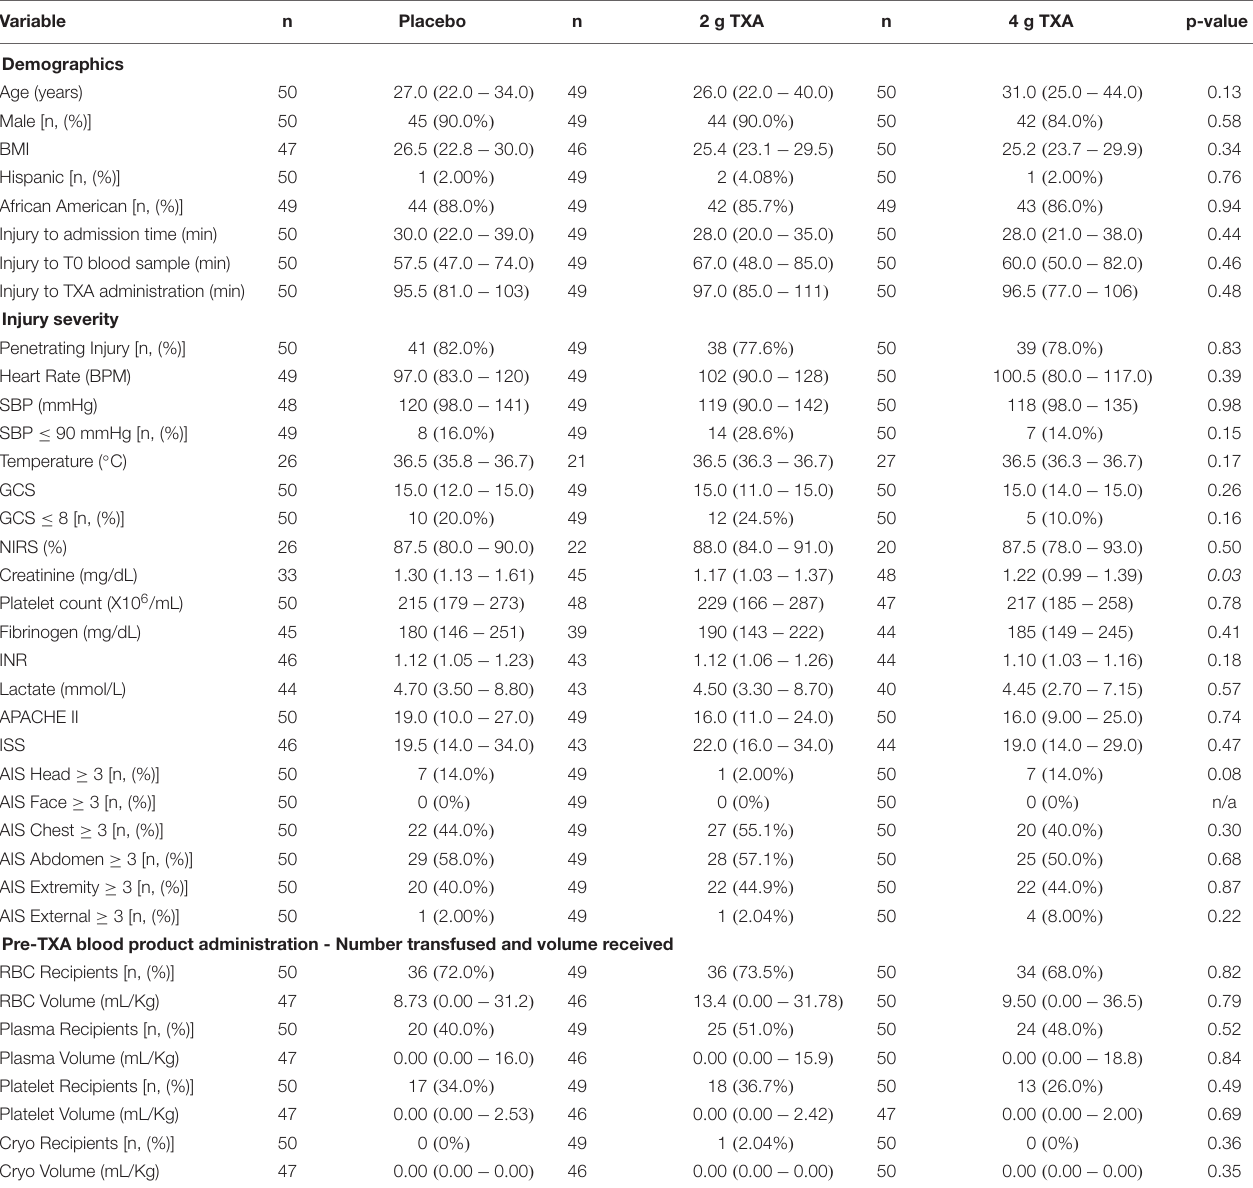
TABLE 1 | Patient demographics, baseline characteristics, and clinical outcomes in each study group. Values are reported as median (Q1–Q3) unless otherwise indicated.